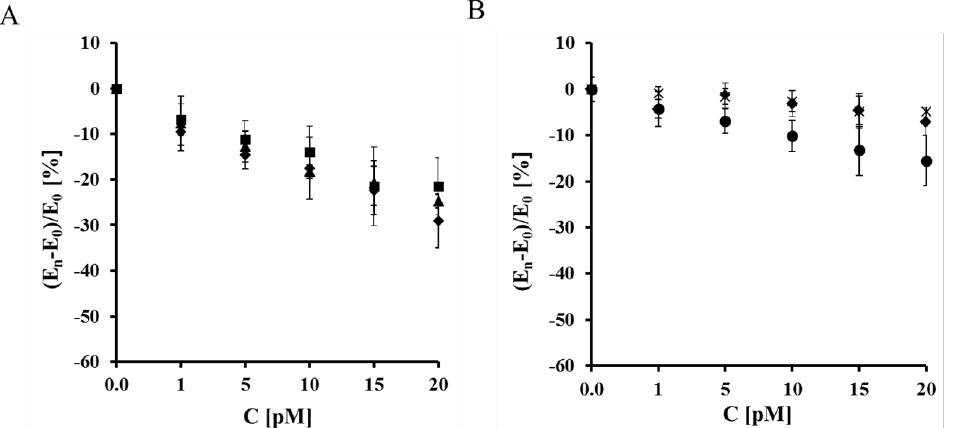
Figure 6. The relationship of ( E electrodes: ( A ) (▲) Au/NAC/DPTA–Cu(II)–His buffer in the presence of Ca 2+ ; (♦) Au/NAC/DPTA–Cu(II)–His domain in diluted human plasma in the presence of Ca 2+ ; (■) Au/NAC/IDA–Cu(II)–His RAGE VC1 natural domain in TRIS buffer with 10 nM Aβ ( B ) (●) Au/NAC/DPTA–Cu(II)–His Ca 2+ ; ( × ) Au/NAC/DPTA–Cu(II)–His presence of Ca 2+ ; (♦) Au/NAC/IDA–Cu(II)–His buffer without of Ca 2+